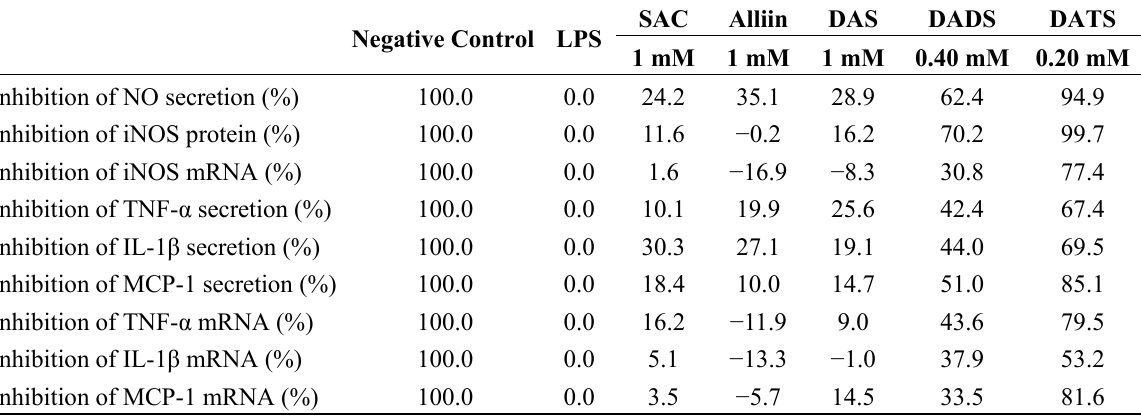
Table 2. Inhibitory rate of the selected OSCs on the proinflammatory mediator secretion and mRNA expression in LPS-activated RAW 264.7